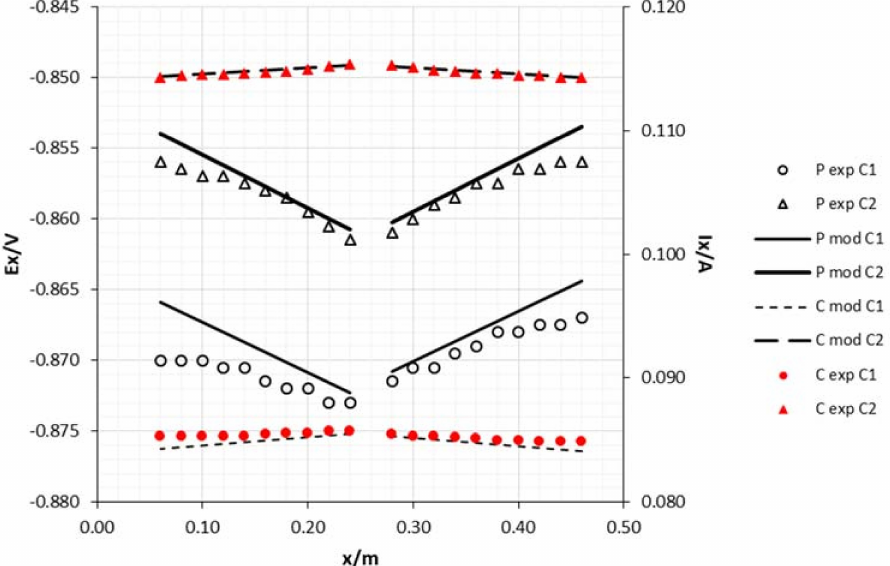
Figure 8. Experimental and model attenuation curves as a function of cathode area (sacrificial anode area: 0.0054 m 2 and middle draining point). Legend: P—potential; C—current; exp—experimental; mod—model; C1—cathode diameter 8 mm; C2—cathode diameter 15